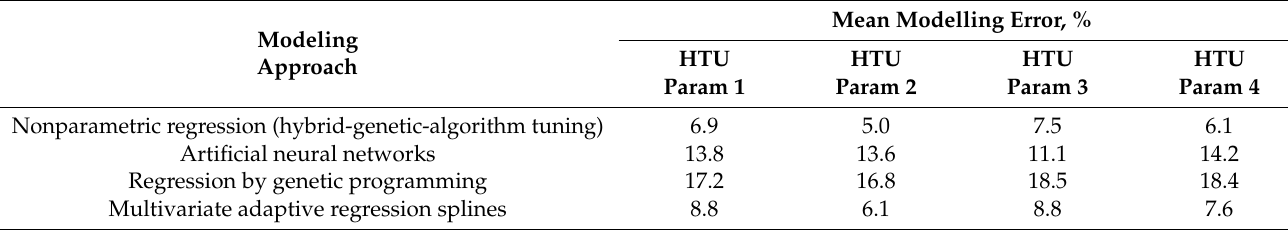
Table 6. Results of the study of modeling approaches on problem of estimating HTU parameters.